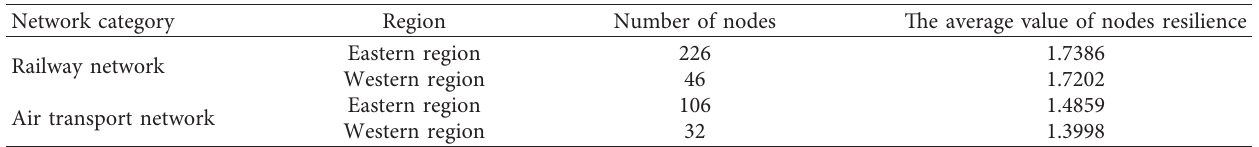
Figure 7: Spatial distribution of resilience in China railway and air transport networks. (a) Railway network. (b) Air transport network. Table 5: Spatial distribution characteristics of nodes